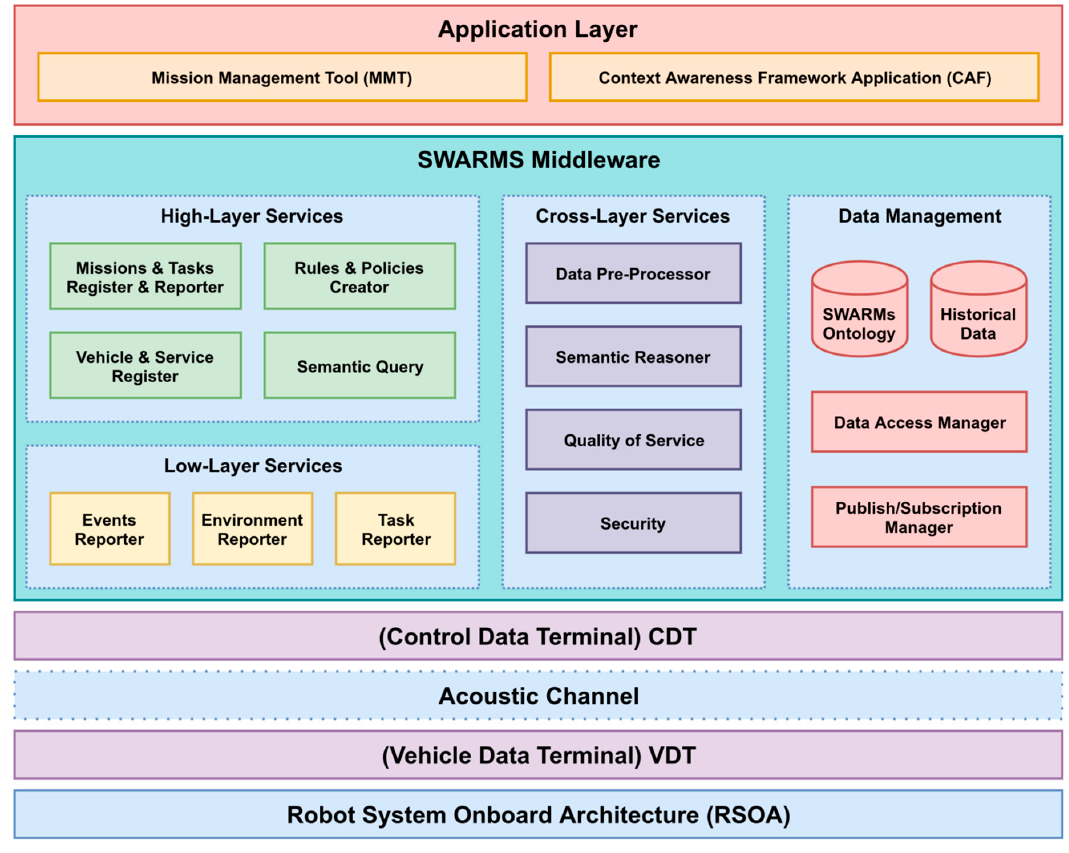
Figure 16. SWARMs middleware architecture.